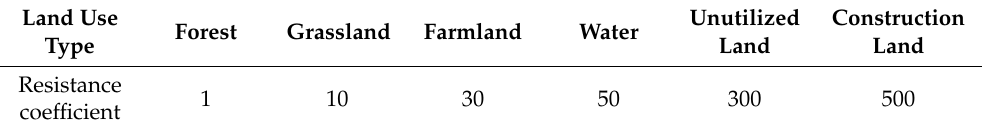
Table 3. Resistance coefficient of land use